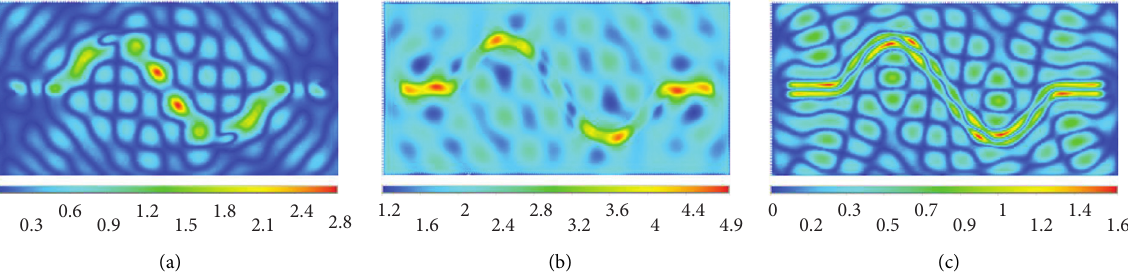
Figure 19: SH wave incident ( f � 2.0Hz, H � 100m, C